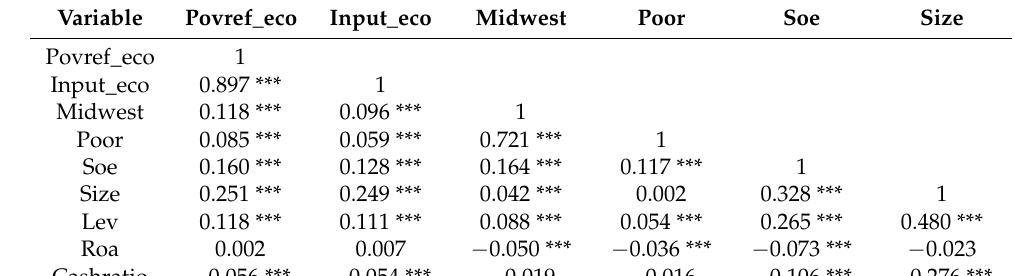
Table A2. Correlation coefficient test. Panel A: Correlation Coefficient of Povref_eco to Size